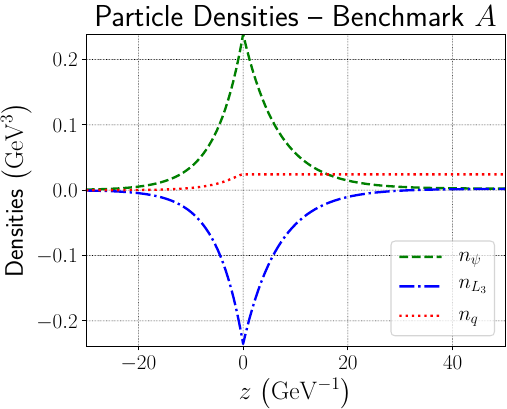
Figure 7. Number densities around the bubble wall for benchmark A using the approximate system of transport equations. Using the full system of equations leads to no visual difference. The green dashed, blue dash-dotted and red dotted lines indicate the ψ , L 3 , and total quark number densities, respectively. The region z > 0 corresponds to the inside of the bubble, where SU(2) is